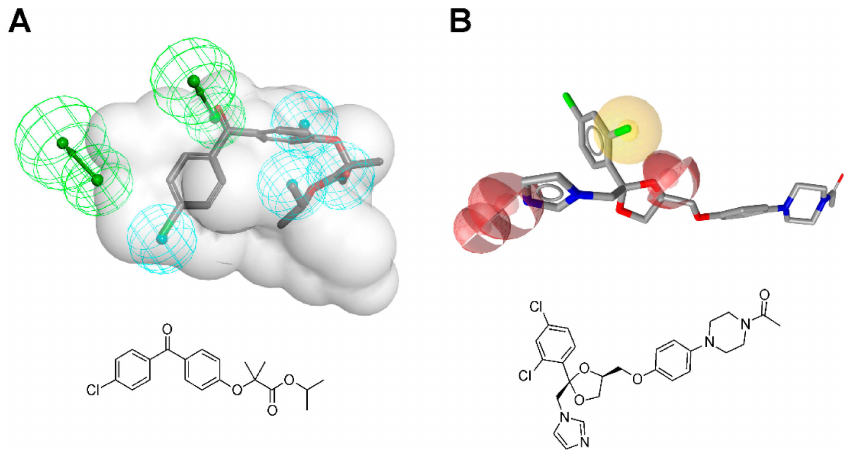
Figure 9. Both the refined 11 β -HSD1 ( A ) and 11 β -HSD2 ( B ) model identified novel scaffolds [29]. The inhibitor fenofibrate maps the 11 β -HSD1 model ( A ) and ketoconazole matches the 11 β -HSD2 model ( B ). Both models were screened with one omitted feature. The 2D structures of the novel inhibitors are depicted underneath the